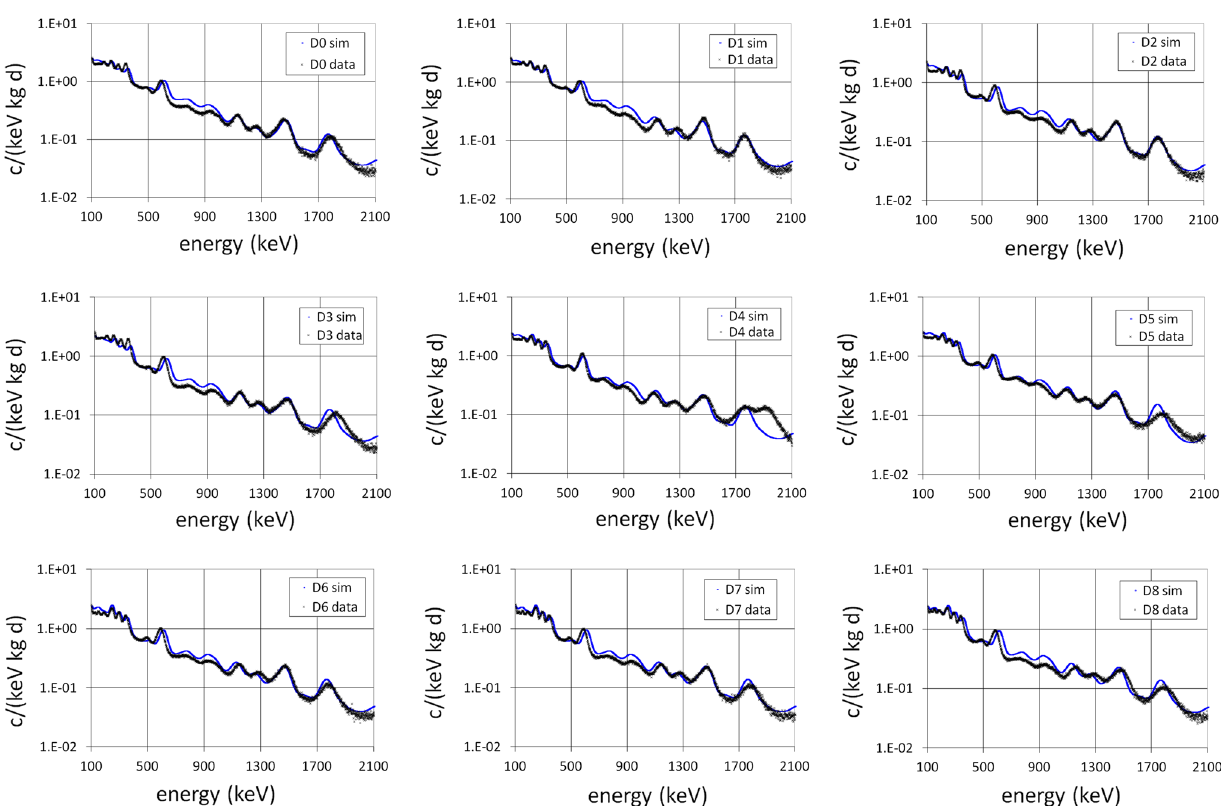
Fig. 8 Comparison of the total energy spectra measured in the first yearofdatatakingforeachdetectorwiththecorrespondingbackground model summing all the simulated contributions. Note that for detector